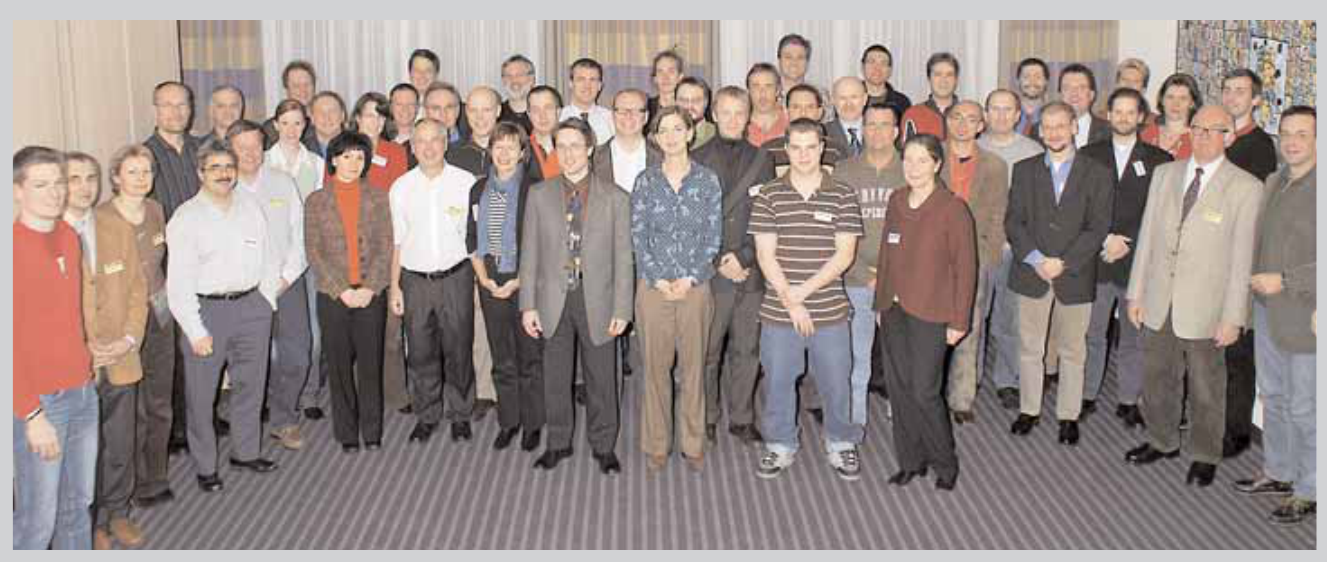
Figure 1: Participants of the 2D/3D rheology seminar in the hotel